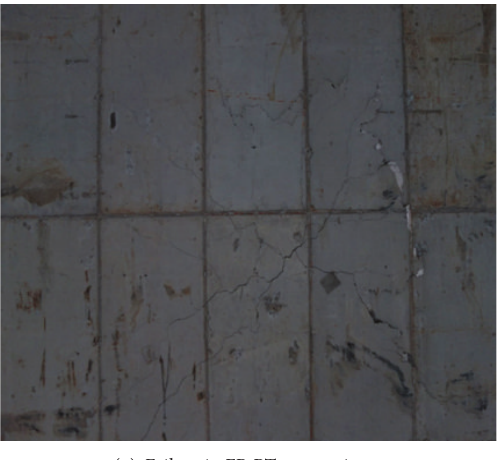
Figure 5: Crack patterns of the specimens.